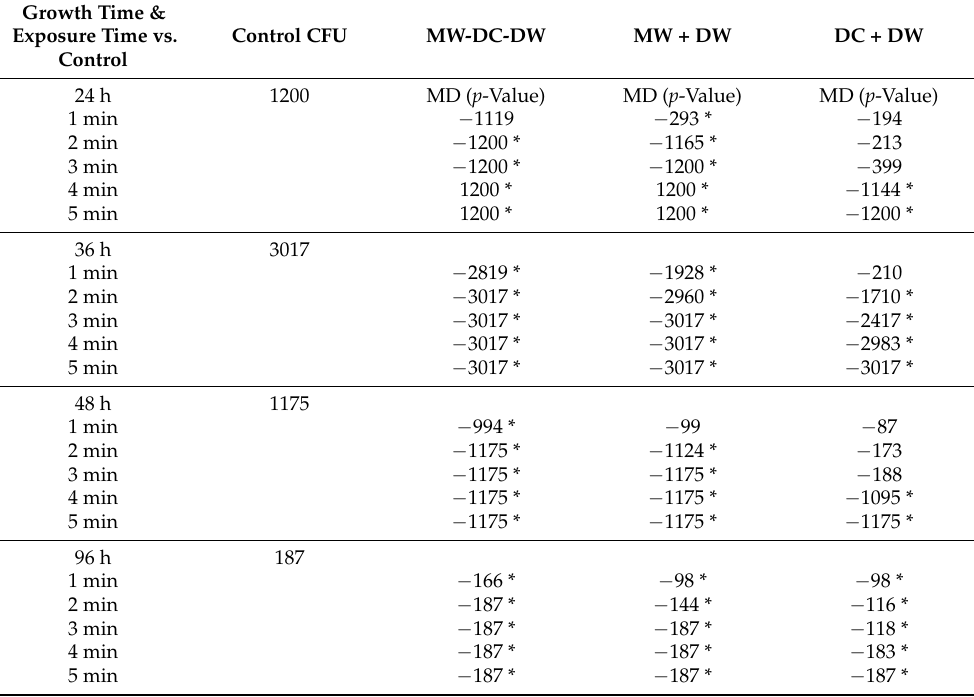
Table 2. Presenting Mean CFU difference among the test and control (non-disinfected) samples for S. aureus . Growth Time & Exposure Time